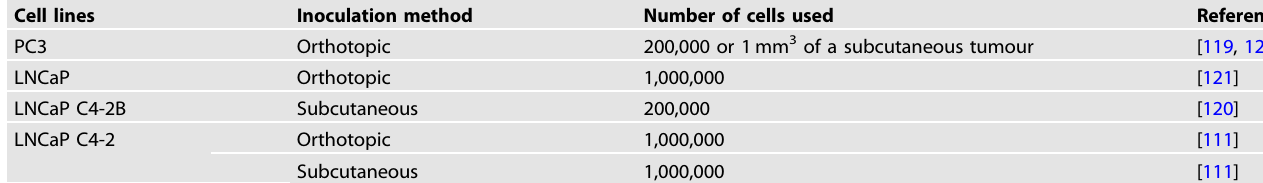
Table 3. Translational models of prostate cancer bone metastasis.